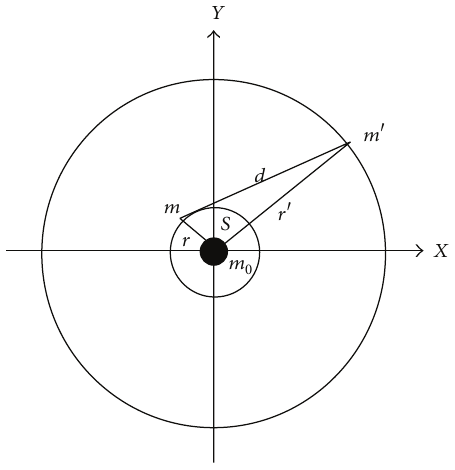
Figure 1: Third-body